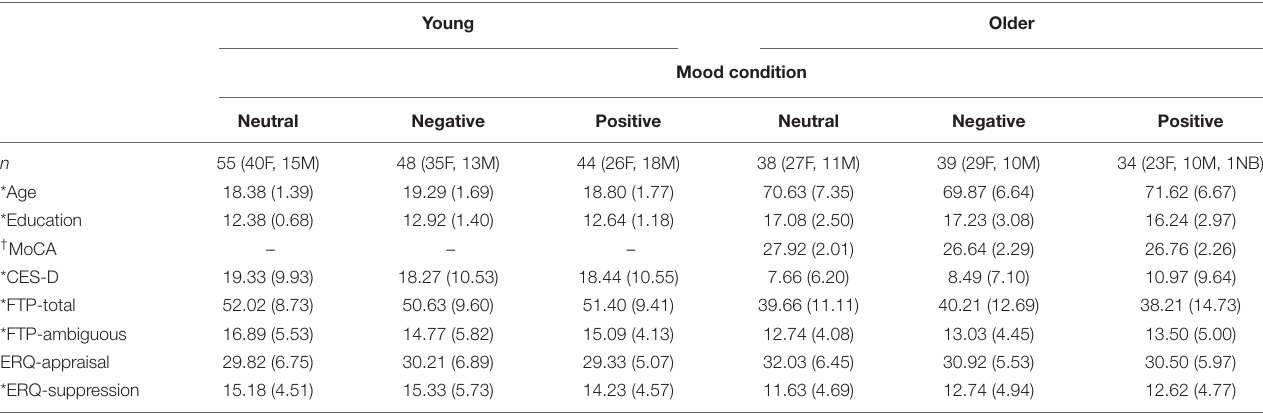
TABLE 1 | Questionnaire data for young and older adults by mood